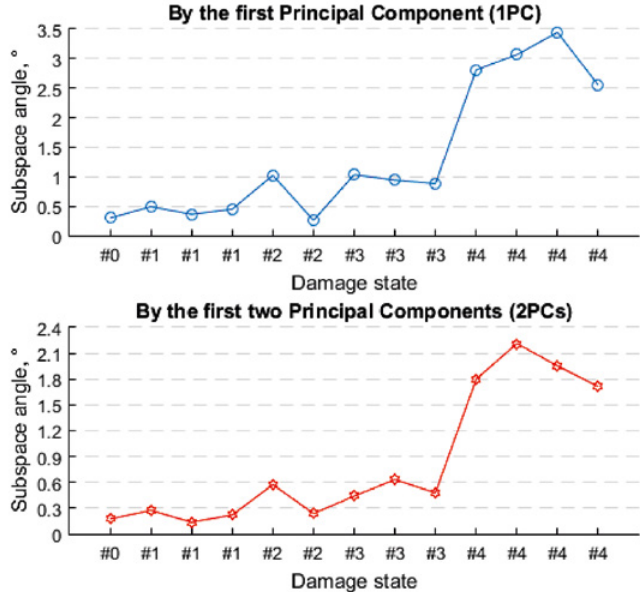
Figure 6 . Damage indexes by subspace angles, the frequency of excitation is nearby f 1